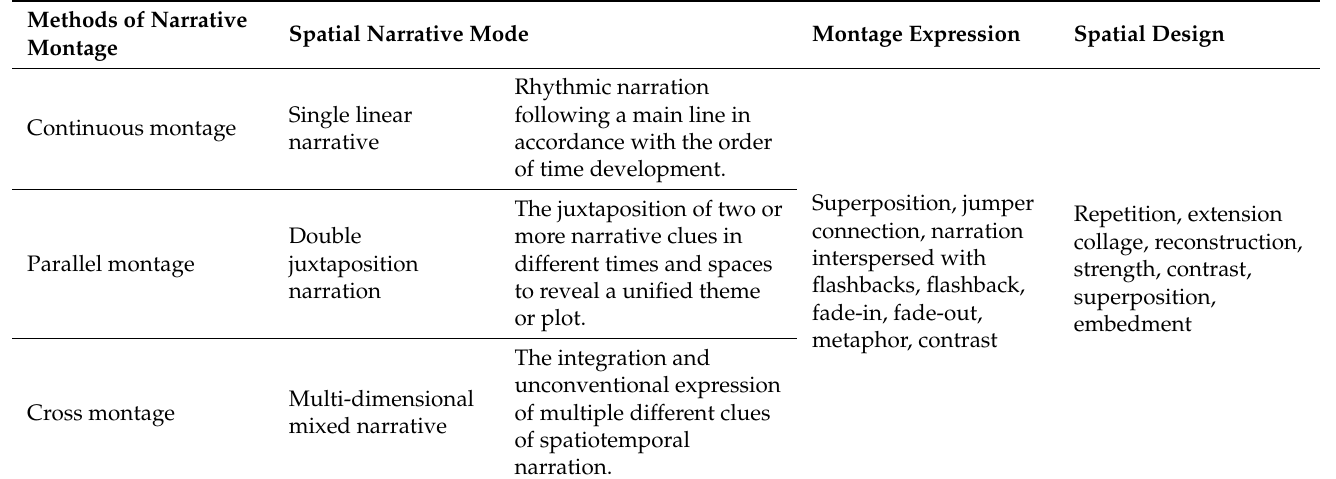
Table 1. Montage and spatial